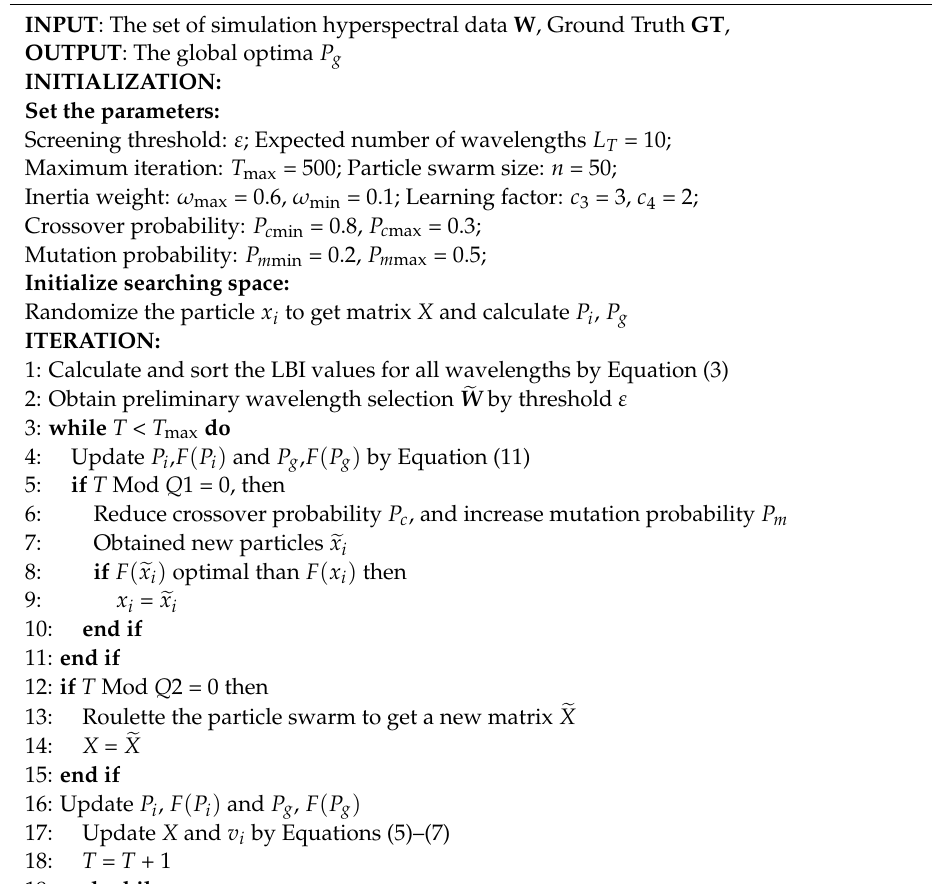
Algorithm 1: Binary Particle Swarm Optimization with Local Band Index